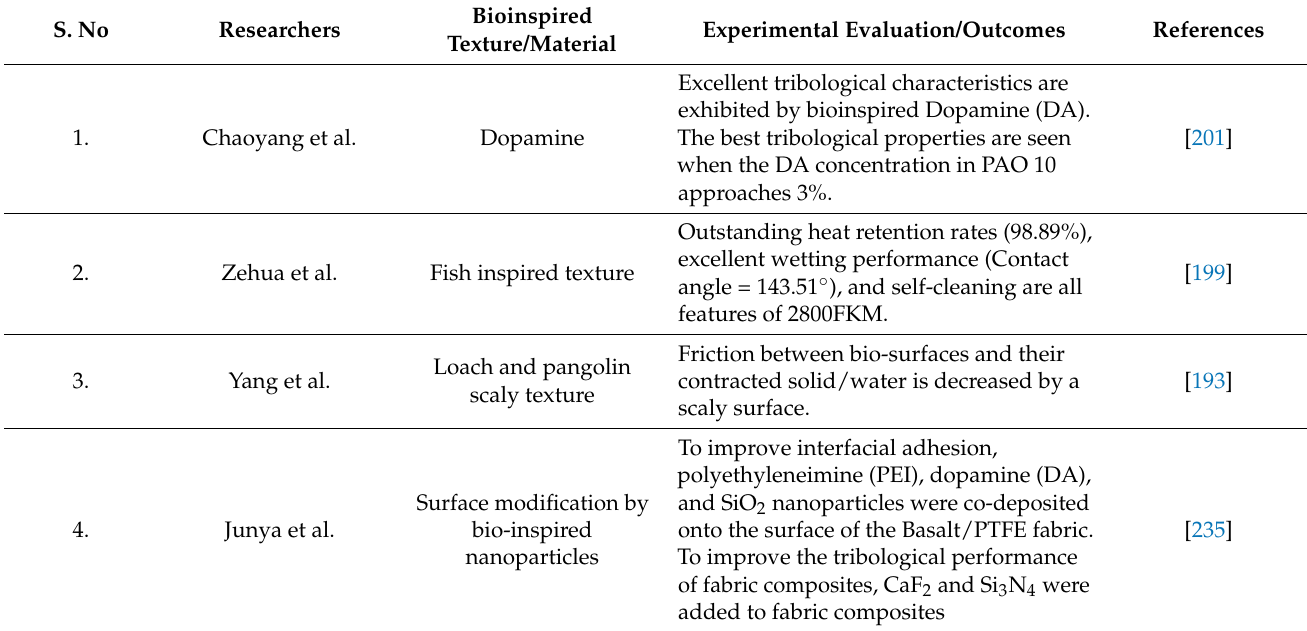
Figure 10. Biomimetics surface resembling the morphology of ( a ) cheetah paws inspired morphology, ( b – e ) tree frog morphology along with scanning electron microscopy of toe pad epithelium at a different scale. The micrographs: ( c ) pads of tree frog, ( d ) showing a mucous pore and (largely)hexagonal epithelial cells separated from each other at their distal ends by channels, and ( e ) indicates the presence of nanostructures on the ‘flat’ surface of the epithelial [176,234]. Copyright permission from Journal of Experimental Biology, 2016. Table 3. Study of different bio-inspired textures and materials for tribological